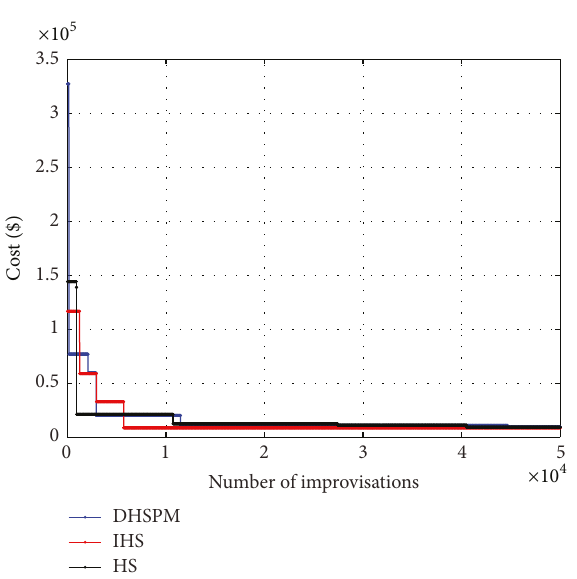
Figure 3: Fuel cost convergence nature of DHSPM, IHS, and HS for 3 thermal units’ system.